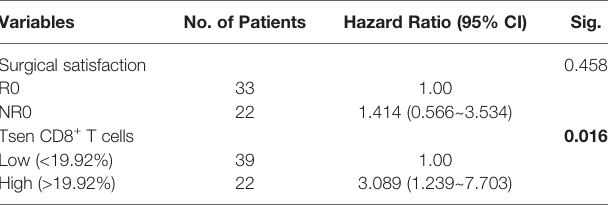
TABLE 5 | Association of Tsen CD8 + T cells in ascites with progression-free survival in patients with advanced HGSOC.